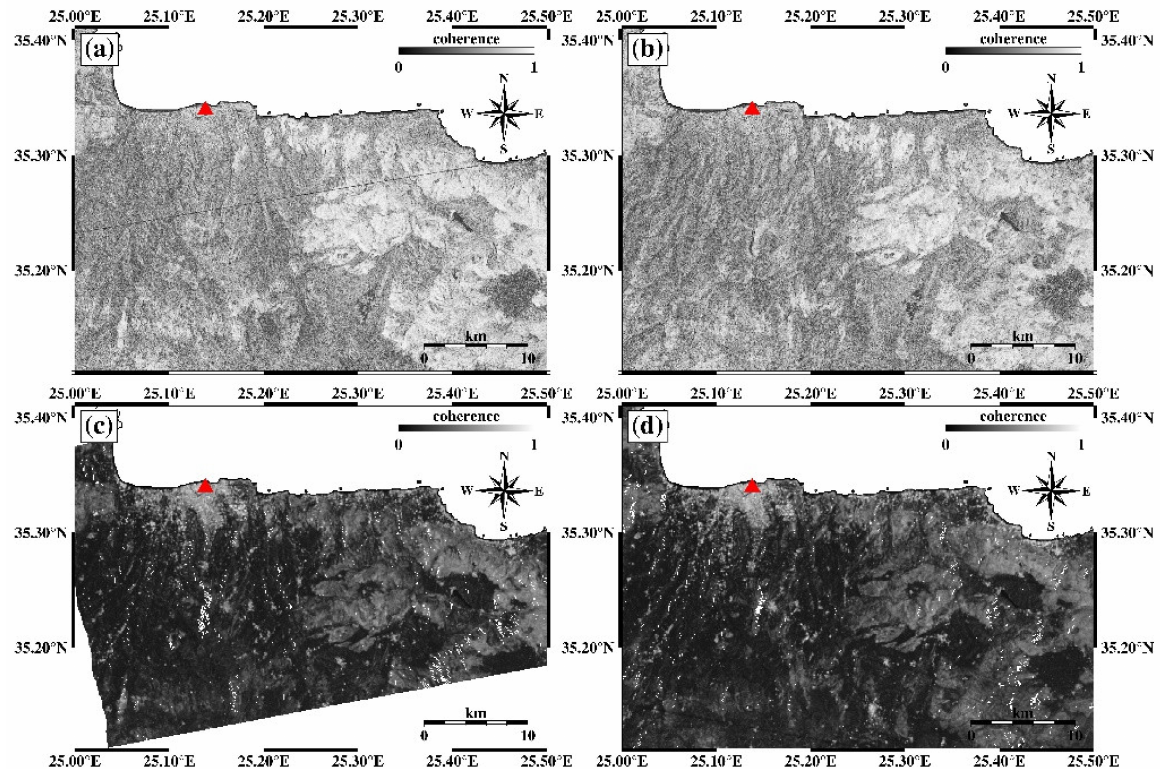
Figure 3. The selection of the reference point (Marked with red triangle). ( a ) Ascending D-InSAR coherence map; ( b ) descending D-InSAR coherence map; ( c ) ascending mean coherence calculated from a stack of 157 coherence maps; ( d ) descending mean coherence calculated from a stack of 152 coherence maps.